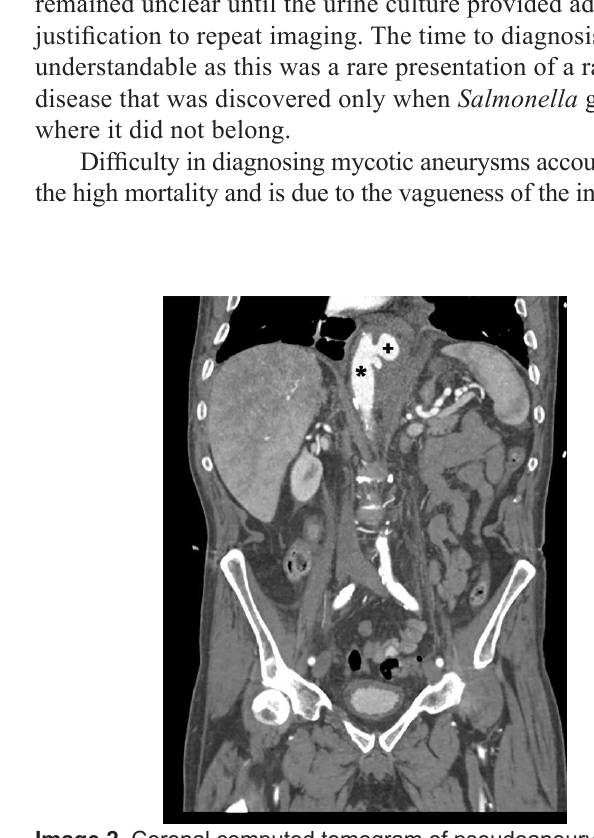
Image 1. Computed tomogram of pseudoaneurysm (+) in descending thoracic aorta (*).